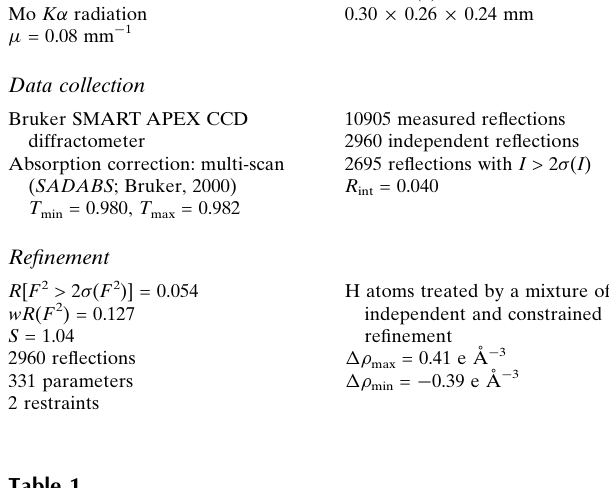
Hydrogen-bond geometry (A˚ , (cid:1)